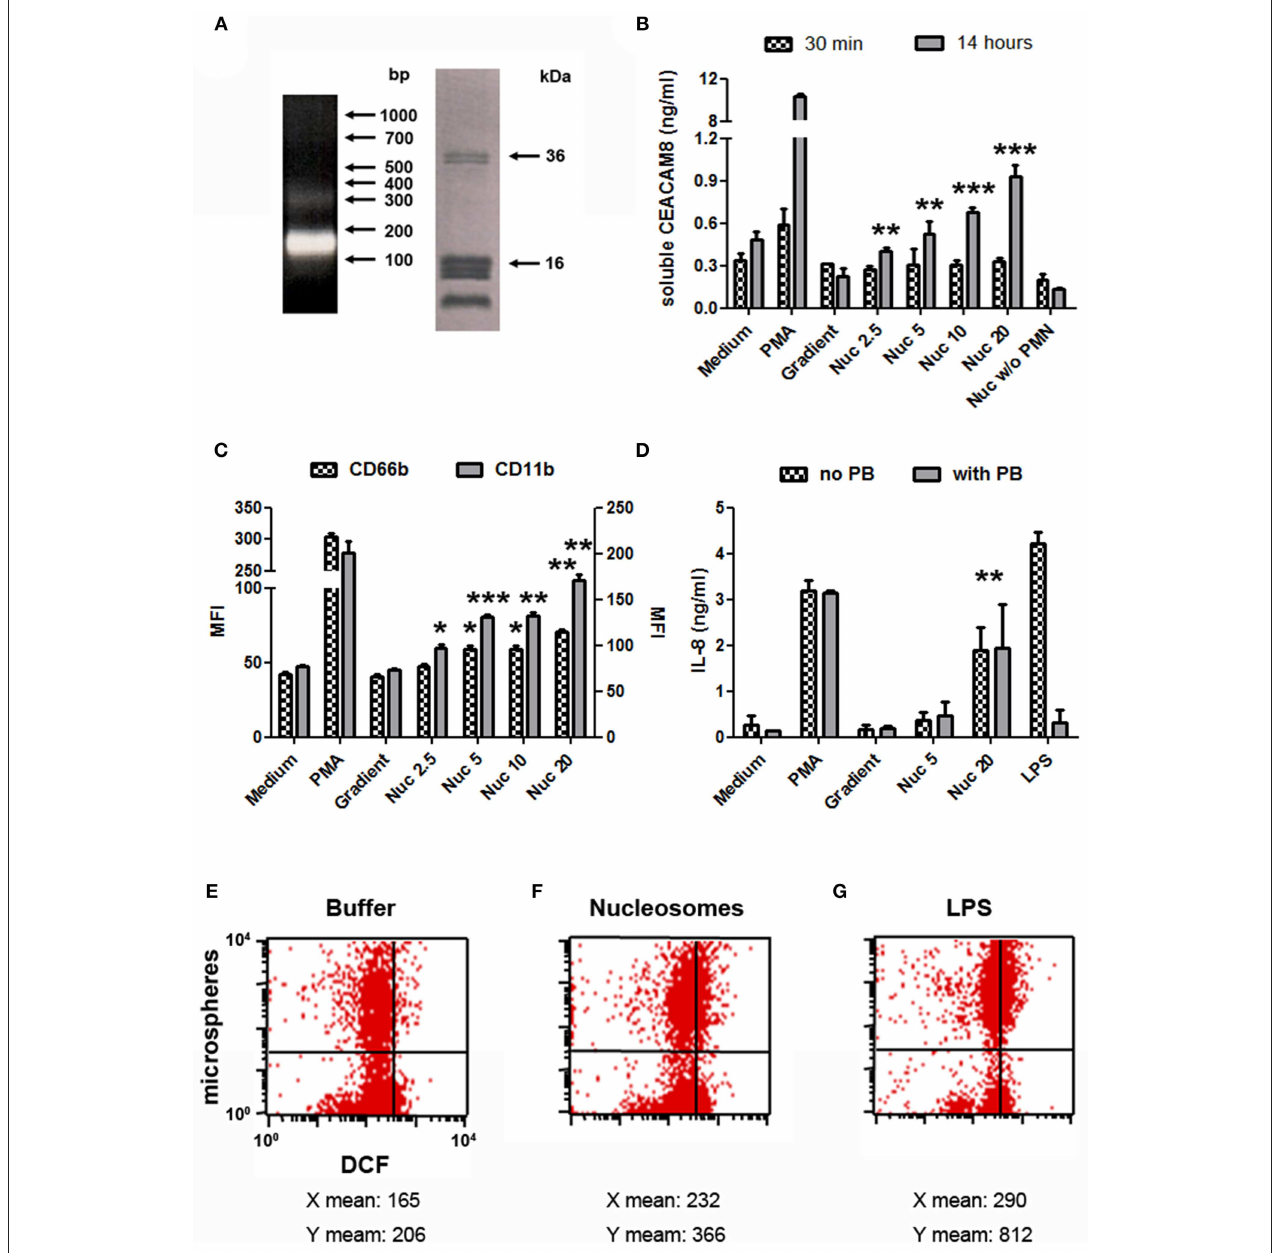
FIGURE 3 | Mono-nucleosome-induced PMN activation leads to secretion of soluble CEACAM8. (A) Chromatin was further purified by ultracentrifugation on 5–29% sucrose gradients to get mono-nucleosomes. Purified nucleosomes were analyzed by 1.5% agarose gel electrophoresis (left) and 18% SDS-PAGE (right). Molecular weight markers are indicated. bp, base pairs. The doublet at ∼ 35 kDa represents histone H1. (B) Freshly isolated human PMN were cultured for 30min or 14h with different stimuli and the release of soluble CEACAM8 was estimated in the supernatants by ELISA. PMA, phorbol myristate acetate; Gradient, empty sucrose gradient loaded with nuclei lysis buffer instead of chromatin; Nuc, purified mono-nucleosomes (2.5, 5, 10, 20 indicate concentrations in µ g/ml). As a control, nucleosomes were incubated without (w/o) PMN. (C,D) PMN were activated as in (B) for 14h and cell activation was estimated by flow cytometry (C) or ELISA (D) . Plasma membrane CD66b (CEACAM8) and CD11b expression and IL-8 secretion were determined. MFI, mean fluorescence intensity. In (D) , PMN were cultured with or without polymyxin B (PB, a LPS antagonist). Shown is one representative experiment of three independent experiments using different donors and different purifications of nucleosomes. Mean and SD of triplicates are shown. (E–G) Chromatin-induced PMN activation leads to increased phagocytic activity and oxidative burst. Freshly isolated human PMN were cultured for 2h in medium supplemented with the chromatin purification buffer (E) or stimulated with 20 µ g/ml purified mono-nucleosomes (F) or 5ng/ml LPS (G) , in the presence of dichlorofluorescin diacetate (which is oxidized in dichlorofluorescein (DCF), x axis) and phycoerythrin-conjugated microspheres (y axis) to measure oxidative burst and phagocytosis, respectively, by flow cytometry. Shown is one representative experiment of three independent experiments using different donors. Mean fluorescence intensities for both axes are depicted below each corresponding dot-plot. LPS, lipopolysaccharides. * p < 0.05; ** p < 0.01; *** p < 0.001 for PMN cultured with nucleosomes vs. the purification buffer.